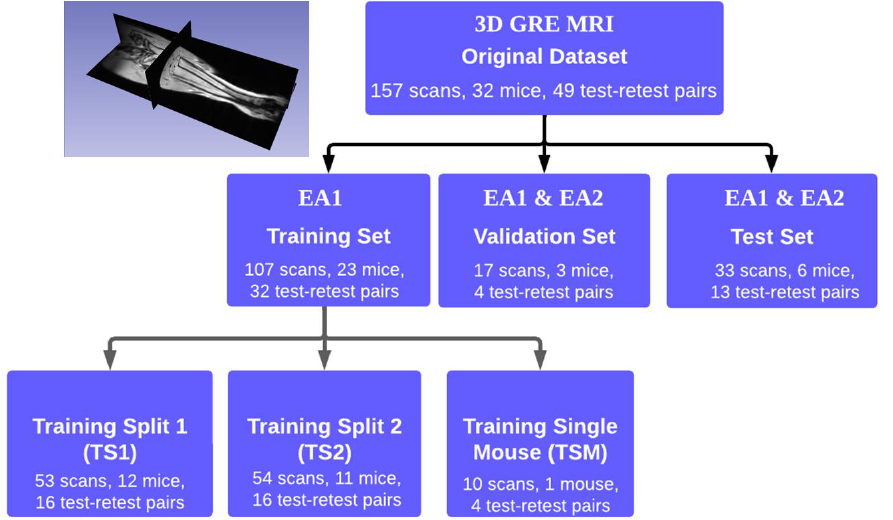
Figure 1. Experimental design diagram showing data content (including repeatability scan pairs) for different A-U-net “training” split scenarios (lower left branches). Data subsets that had manual segmentations by Expert Annotator 1 and 2 (EA1 and EA2) available are marked in the middle branches. The inset shows an example of 3D MRI image for mouse tibia with three orthogonal view projection planes.